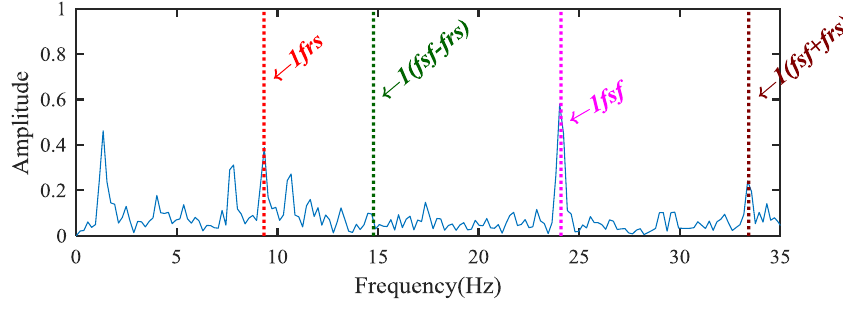
Figure 7. The envelope spectrum of the reconstruction signal. Table 3. The frequency range of 4-layer wavelet packet decomposition.